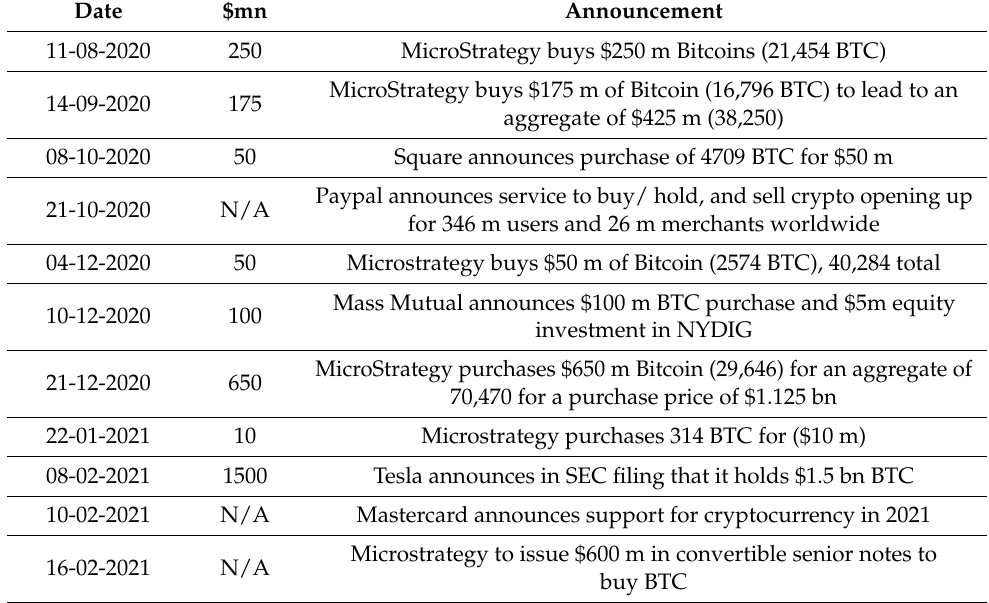
Table 2. Notable recent Institutional announcements of Bitcoin adoption.